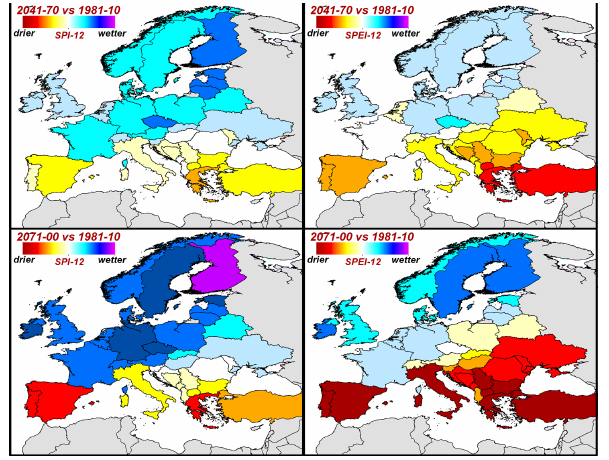
Figure 3. Country tendencies towards drier or wetter near and far future, according to the SPI-12 (left panel) and the SPEI-12 (right